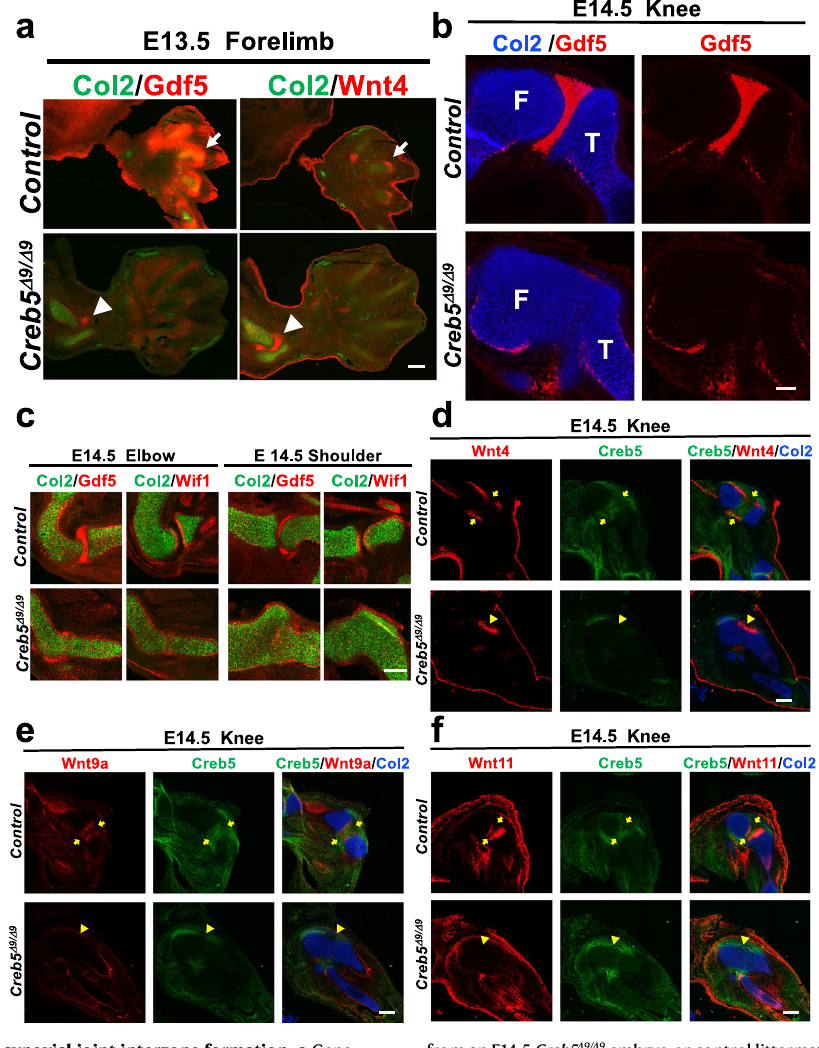
from an E14.5 Creb5 Δ 9/ Δ 9 embryo or controllittermate. d – f Geneexpression assayed by RNAscope FISH in serial sections of the knee of an E14.5 Creb5 Δ 9/ Δ 9 embryo or control littermate. In control limbs, the location of the articular perichondrium between the separated cartilage elements (yellowarrows) isindicated. In Creb5 Δ 9/ Δ 9 mutant limbs, the junction of the fused cartilage elements (yellow arrowheads) is indicated. Similar results were obtained in at least two independent biological repeats. Scale bar equals 200 microns, unless indicated